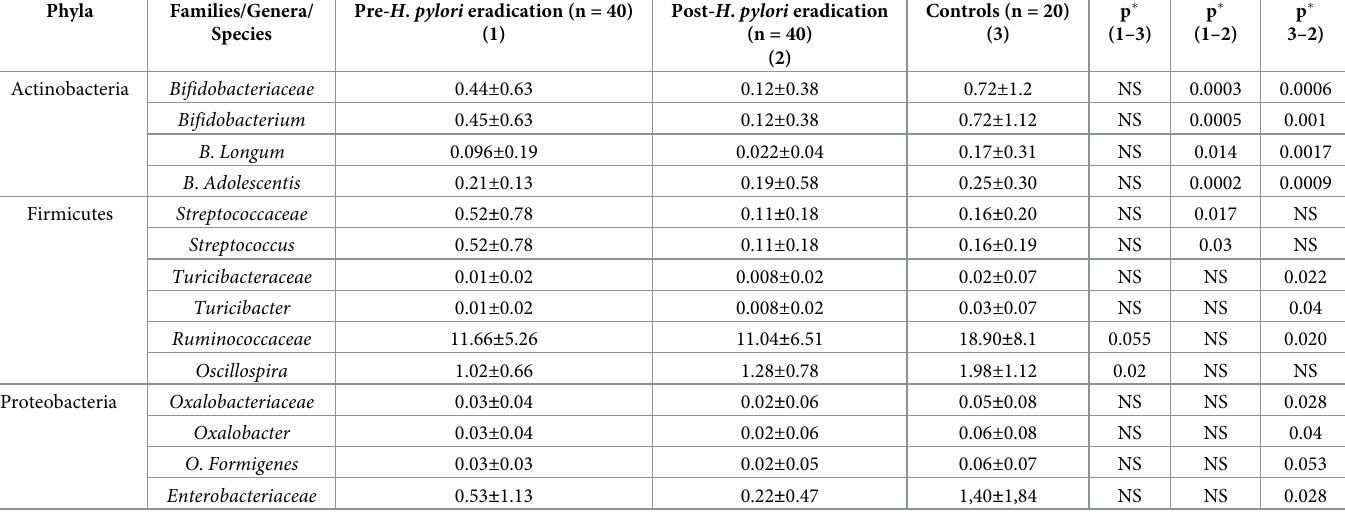
Table 3. Comparison of relative abundance of families, genera and species between controls and patients before and two months after H . pylori eradication treat- ment within the phyla Actinobacteria, Firmicutes, Proteobacteria.